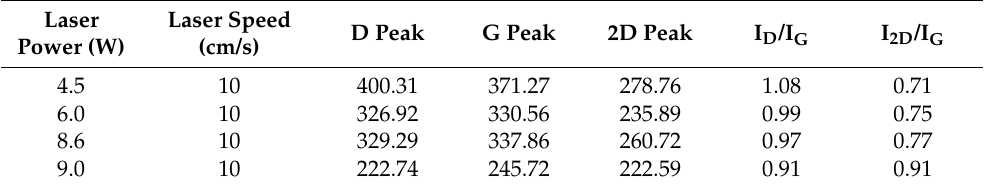
Table 1. Raman spectrogram intensities of the D, G, and 2D peaks and their ratios. Laser Power